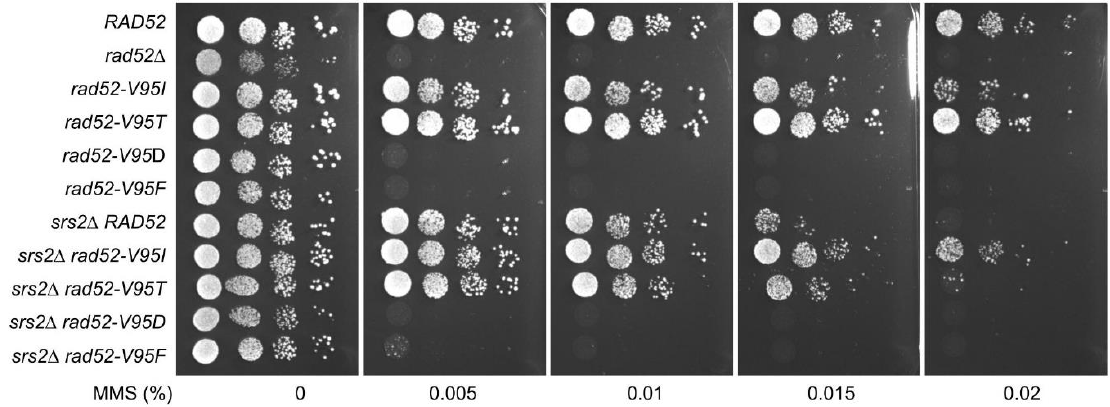
Figure 3. Effect of different V95 mutations on MMS sensitivity and Srs2-deficient cell suppression. Serial 10-fold dilutions of haploid strains with the indicated genotypes were spotted onto rich medium (YPD) containing different MMS concen- trations.